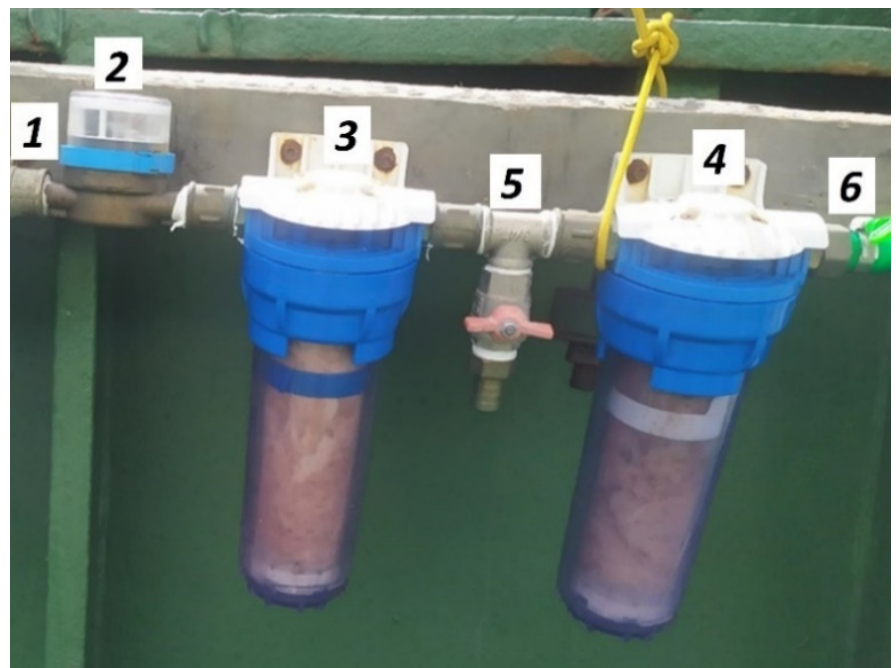
Figure 1. Installation for sorption of radionuclides from large samples (more than 1 m 3 ) of pre-fil- tered seawater: 1—water inlet pipe; 2—water meter; 3, 4—first and second stages of sorption (car- tridge volume 700 mL); 5—sample pipe after the first stage; 6—pipe for water outlet after sorption.